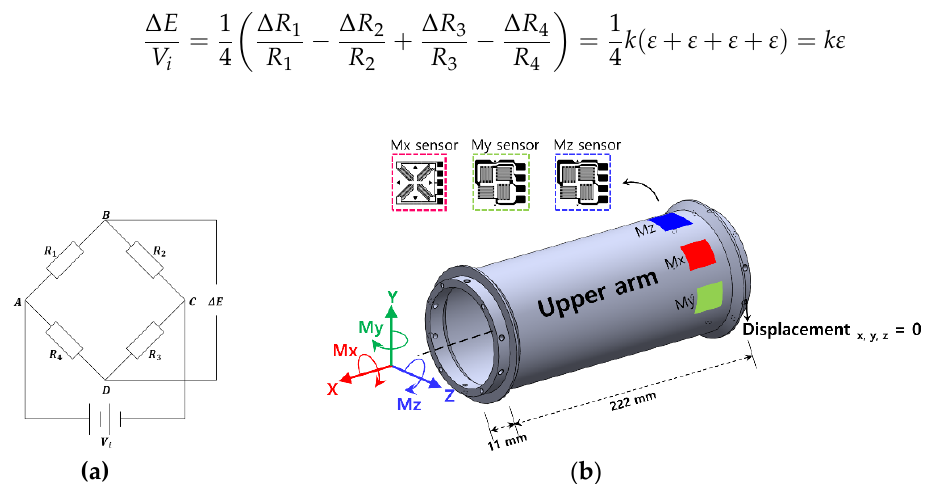
Figure 2. Collision detection system configuration using Wheatstone bridge; ( a ) Wheatstone bridge circuit used for measurements; ( b ) attach a strain gauge to the link surface to collision detection.